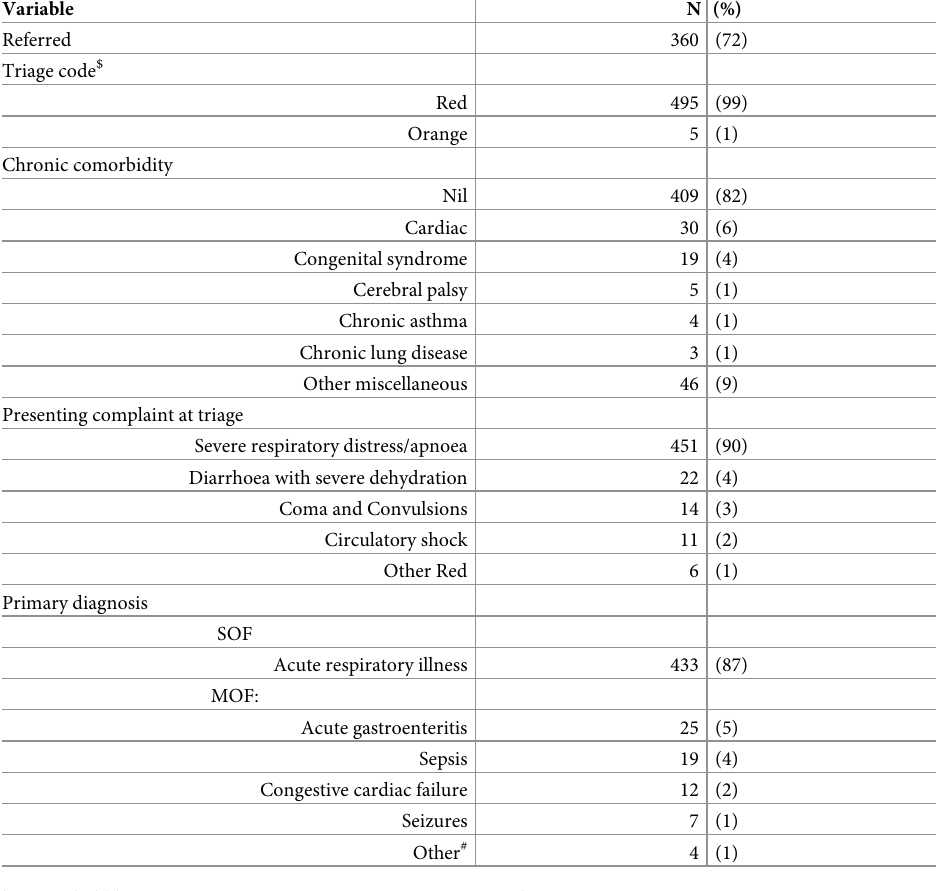
Table 2. Clinical characteristics of the children started on bCPAP outside of PICU (N =